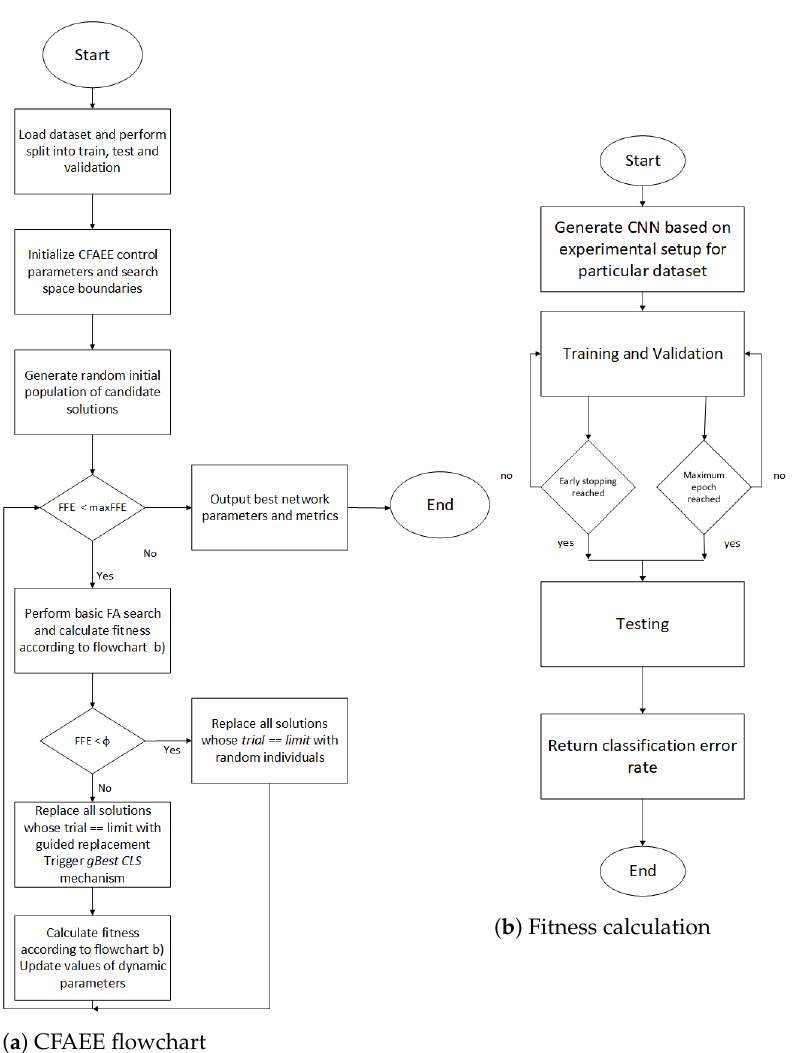
Figure 6. ( a ) General CFAEE flowchart ( left ); ( b ) flowchart for fitness calculation ( right